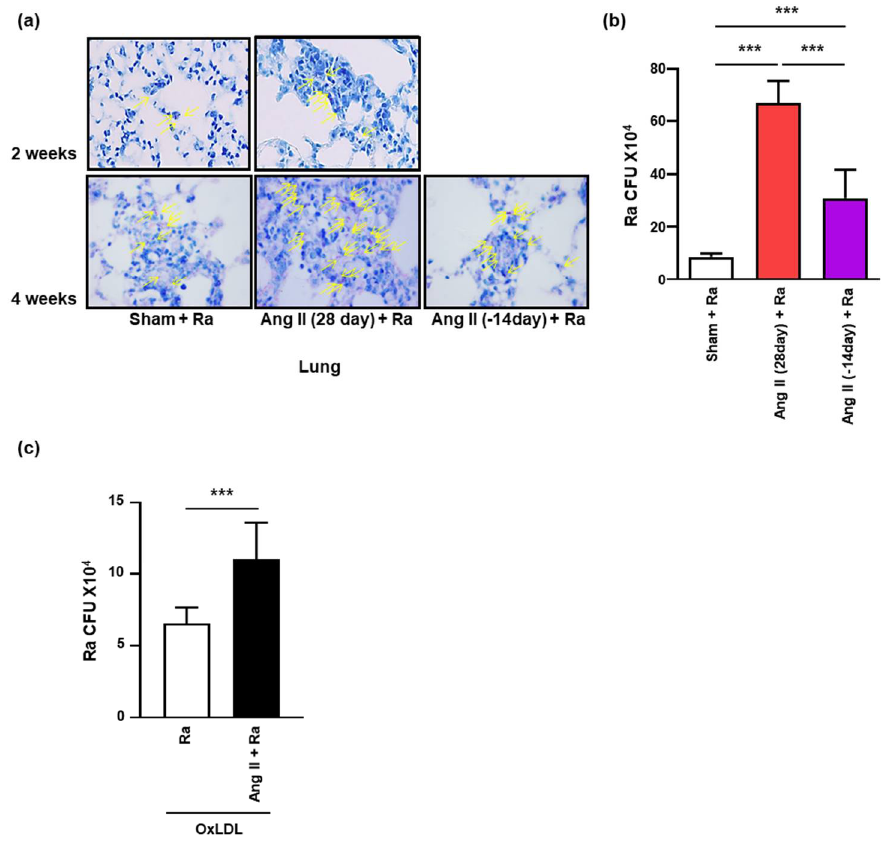
Figure 6. Ang II-induced hypertensive condition promotes the intracellular survival of myocbac- teria. Hypertension was induced in C57BL/6 mice by Ang II (0.7 mg/kg/day) infusion using an osmotic mini-pump for 14 or 28 days. PBS was used in the control group. Mice were infected with Mtb H37Ra (1 × 10 6 CFU) by intratracheal injection at after 1 week of Ang II infusion. ( a ) Acid-fast bacillus (arrows) staining was performed in lung tissues of Mtb H37Ra (1 × 10 6 CFU)-infected mice after 2 or 4 weeks of Ang II infusion (magnification, 40×). Data are presented as representative pictures of each group. ( b ) The total number of Mtb H37Ra was counted by CFU analysis in the lungs of five infected mice in each group. ( c ) BMDM cells were pretreated with Ang II (1 μM) for 1 h followed by incubation with 50 μg/mL OxLDL after Mtb H37Ra (MOI = 1) infection. Intracellular bacterial survival was measured by enumeration of CFU at 48 h after infection. Data are shown as means ± SD (*** p < 0.001).